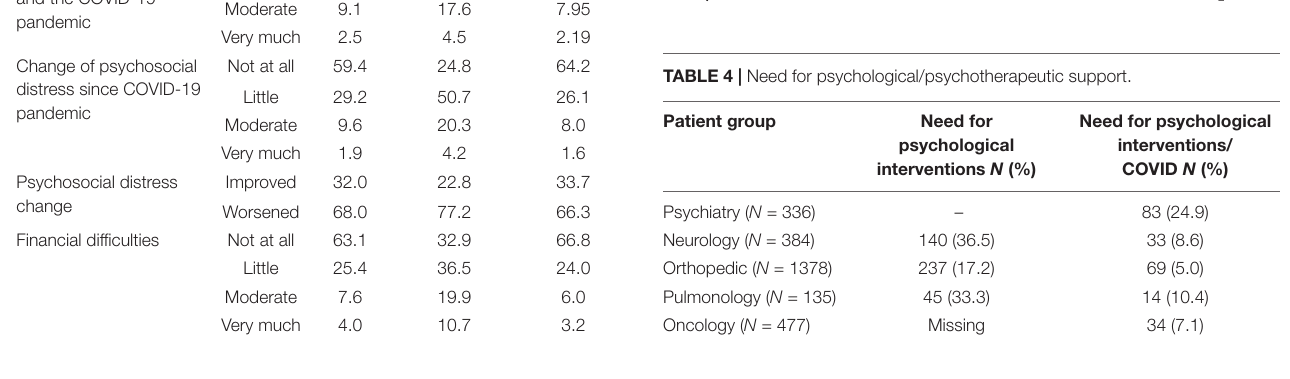
financial resources are relevant barriers for psychological and psychotherapeutic support.